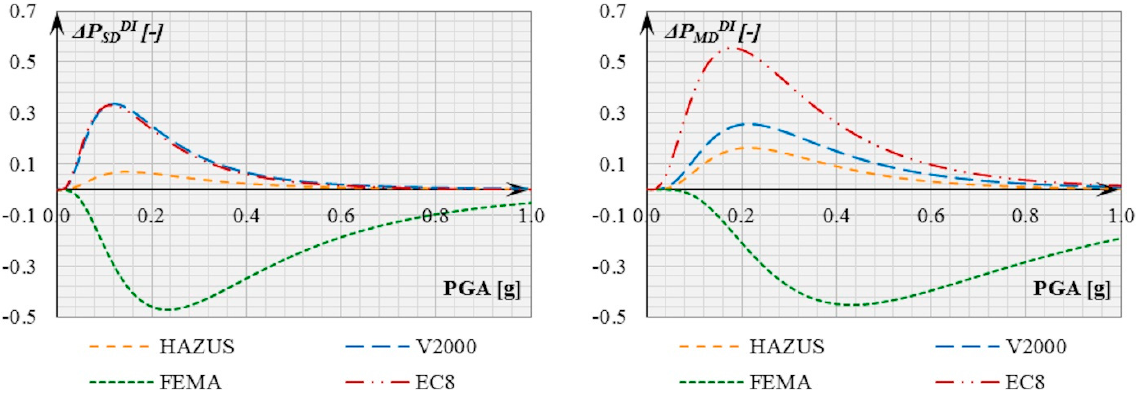
Figure 25. Differences between fragility curves calculated using other methods and the ones calculated using the modified DI method, for the damage states SD ( left ) and MD ( right ).